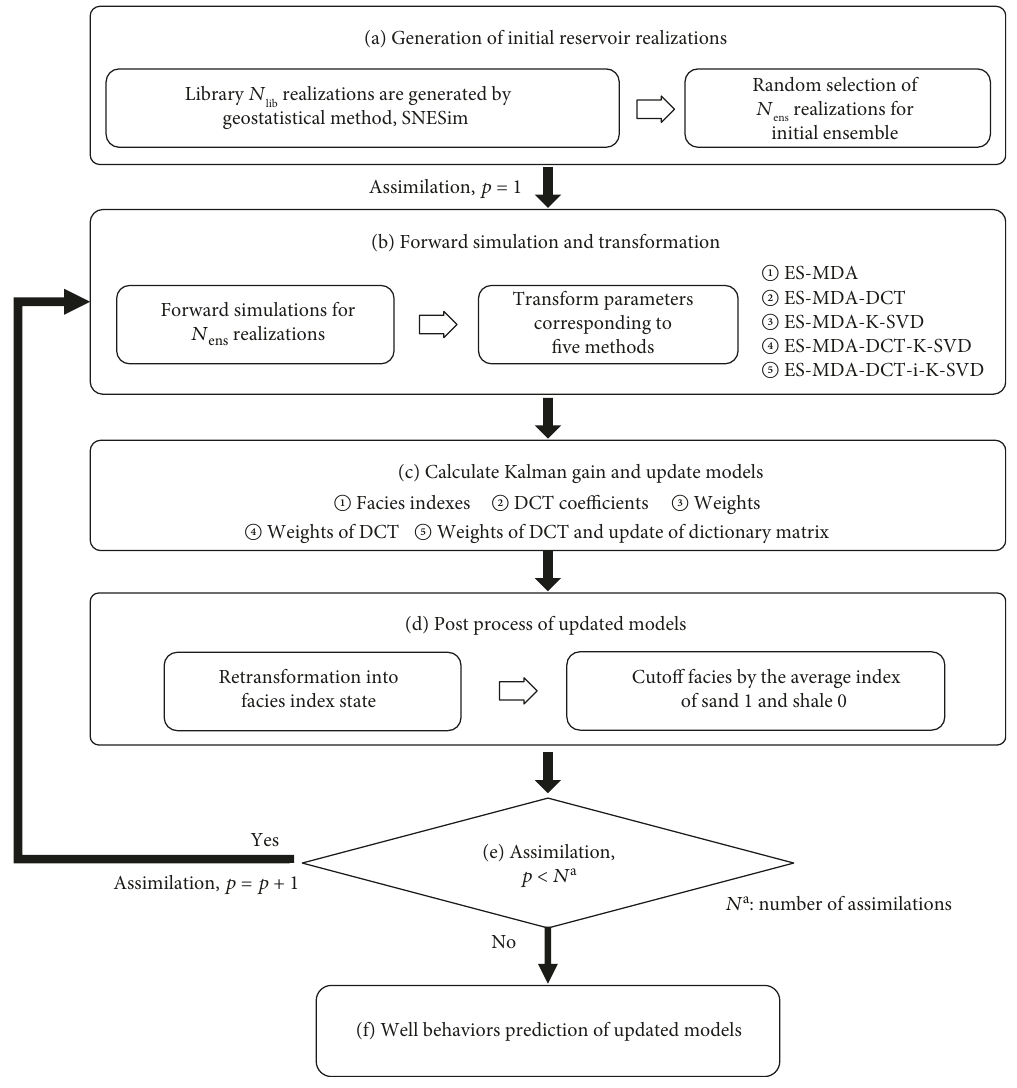
Figure 5: Flow chart of fi ve ES-MDA algorithms investigated in this study. The proposed algorithm corresponds to the number fi ve in the boxes (b) and